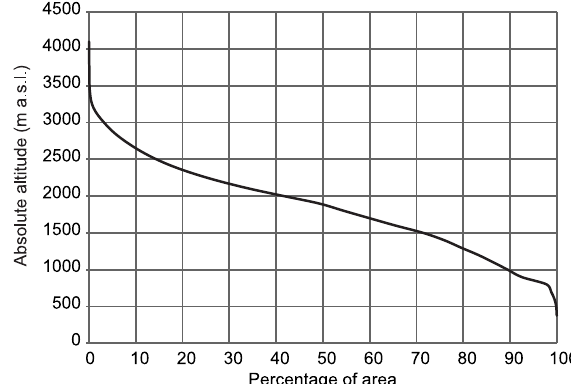
Fig. 2. Percentage hypsometric curve of the territory of Armenia.